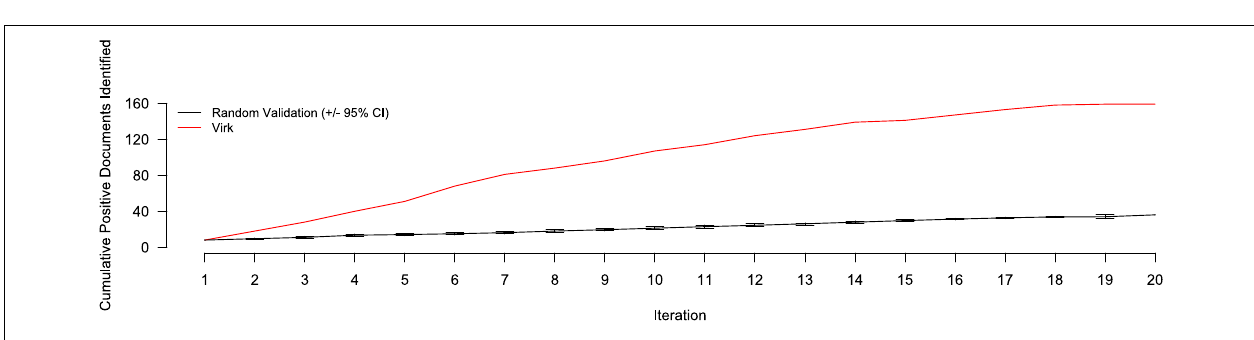
FIGURE 5 | Number of positive-class documents identified over 20 iterations by Virk (red line) and Random Validation (black line, ± 95% confidence interval). After 20 iterations, the random validation system identified the number of positives found after only three iterations of the Virk system.